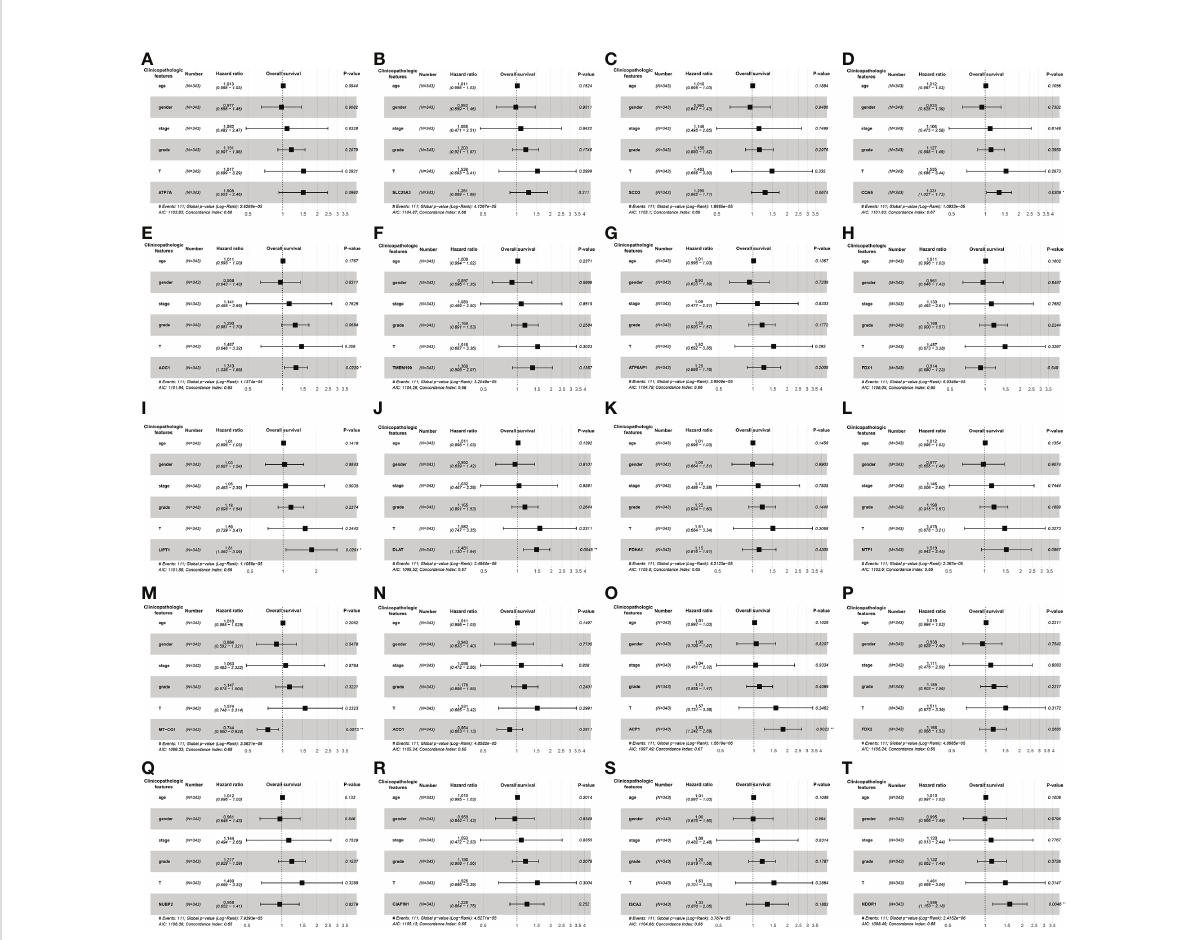
FIGURE 5 The forest plots of multivariate Cox analysis about screened cuproptosis-related gene expression levels among hepatocellular carcinoma (HCC) patients from TCGA. The forest plot was generated to show the connection between clinicopathological features and the cuproptosis-related genes expression level of HCCs, including ATP7A (A) , SLC25A3 (B) , SCO2 (C) , COA6 (D) , AOC1 (E) , TMEM199 (F) , ATP6AP1 (G) , FDX1 (H) , LIPT1 (I) , DLAT (J) , PDHA1 (K) , MTF1 (L) , MT- CO1 (M) , ACO1 (N) , ACP1 (O) , FDX2 (P) , NUBP2 (Q) , CIAPIN1 (R) , ISCA2 (S) , and NDOR1 (T) . (ACO1, aconitase 1; ACP1, acid phosphatase 1; AOC1, amine oxidase copper containing 1; ATP6AP1, ATPase H+ transporting accessory protein 1; ATP7A, copper-transporting p-type adenosine triphosphatase 1; CIAPIN1, cytokine induced apoptosis inhibitor 1; COA6, cytochrome c oxidase assembly factor 6; DLAT, dihydrolipoamide S-acetyltransferase; FDX1, ferredoxin 1; FDX2, ferredoxin 2; Grade, histologic grade; HCC, hepatocellular carcinoma; ISCA2, iron-sulfur cluster assembly 2; LIPT1, lipoyltransferase 1; MT-CO1, mitochondrially encoded cytochrome c oxidase I; MTF1, metal regulatory transcription factor 1; NDOR1, NADPH dependent di fl avin oxidoreductase 1; NUBP2, nucleotide binding protein 2; PDHA1, pyruvate dehydrogenase E1 subunit alpha 1; SCO2, synthesis of cytochrome c oxidase 2; SLC25A3, solute carrier family 25 member 3; Stage, clinical stage; T, tumor stage; TCGA, The Cancer Genome Atlas; TMEM199, transmembrane protein 199; * P < 0.05; ** P < 0.01; *** P <